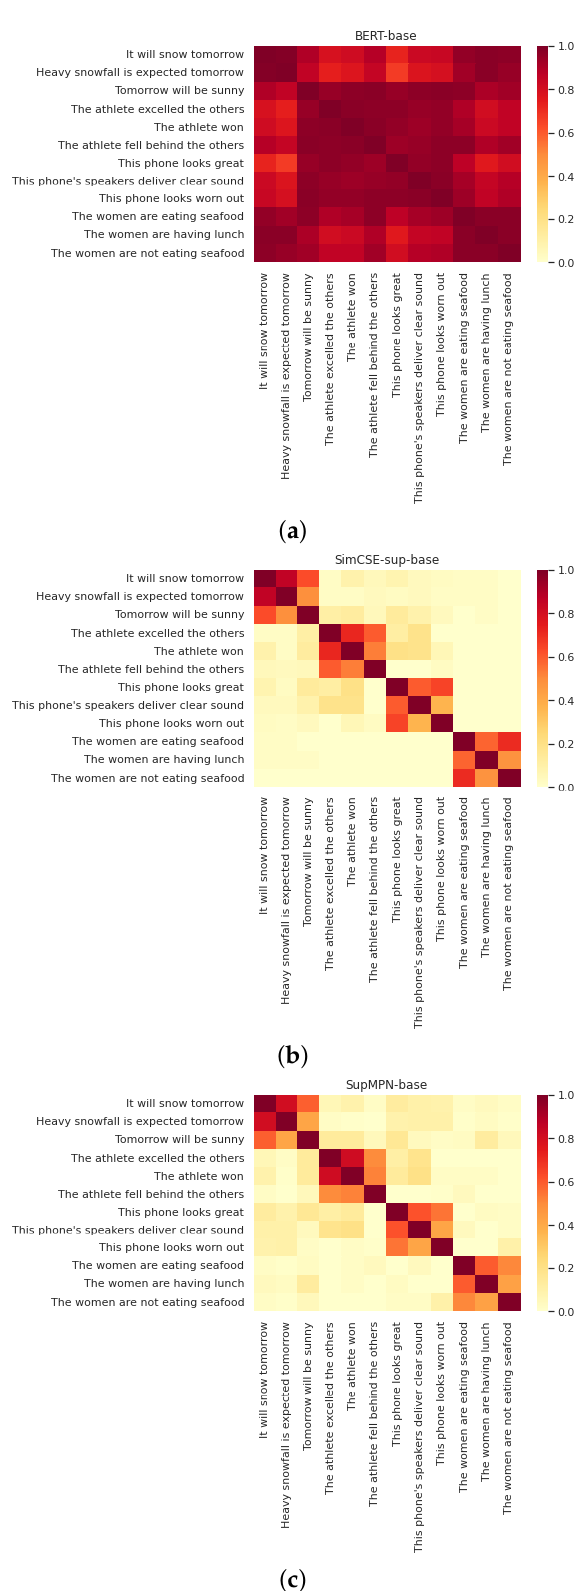
Figure 2. Semantic textual similarity using sentence embeddings from ( a ) BERT, ( b ) SimCSE sup , and ( c ) SupMPN, starting from BERT-base checkpoint, on four topics, weather, sport, smartphone, and food. We used cosine similarity for